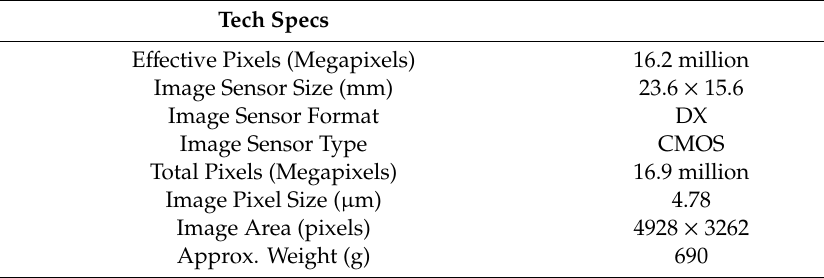
Table 2. Technical specifications of the camera used in this study (a Nikon D7000).